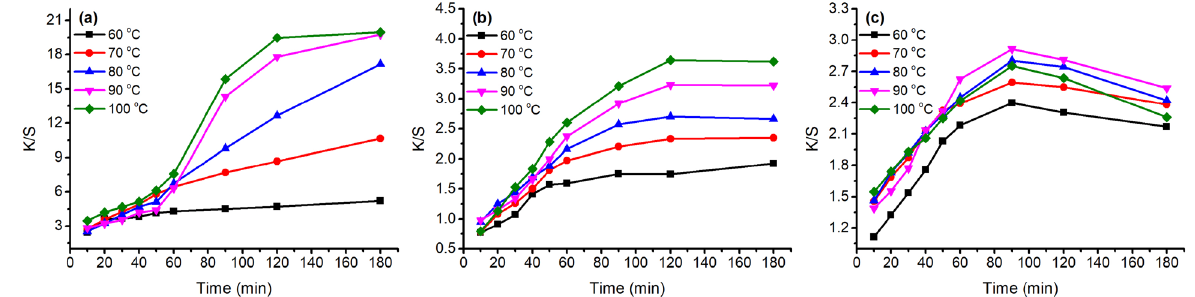
Figure 7. Color strength (K/S) of dyed wool fiber with 2% o.m.f of ( a ) MR, ( b ) GB, and ( c ) GY dyes in water at pH 4 and 60–100